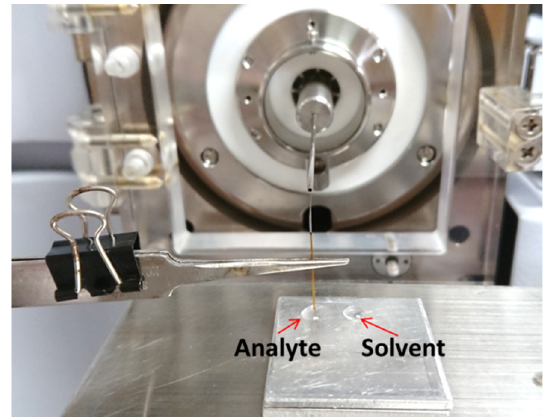
Figure 1. Photograph of the hyphenated technique using a short and tapered capillary as the separation/concentration channel and the ionization emitter.